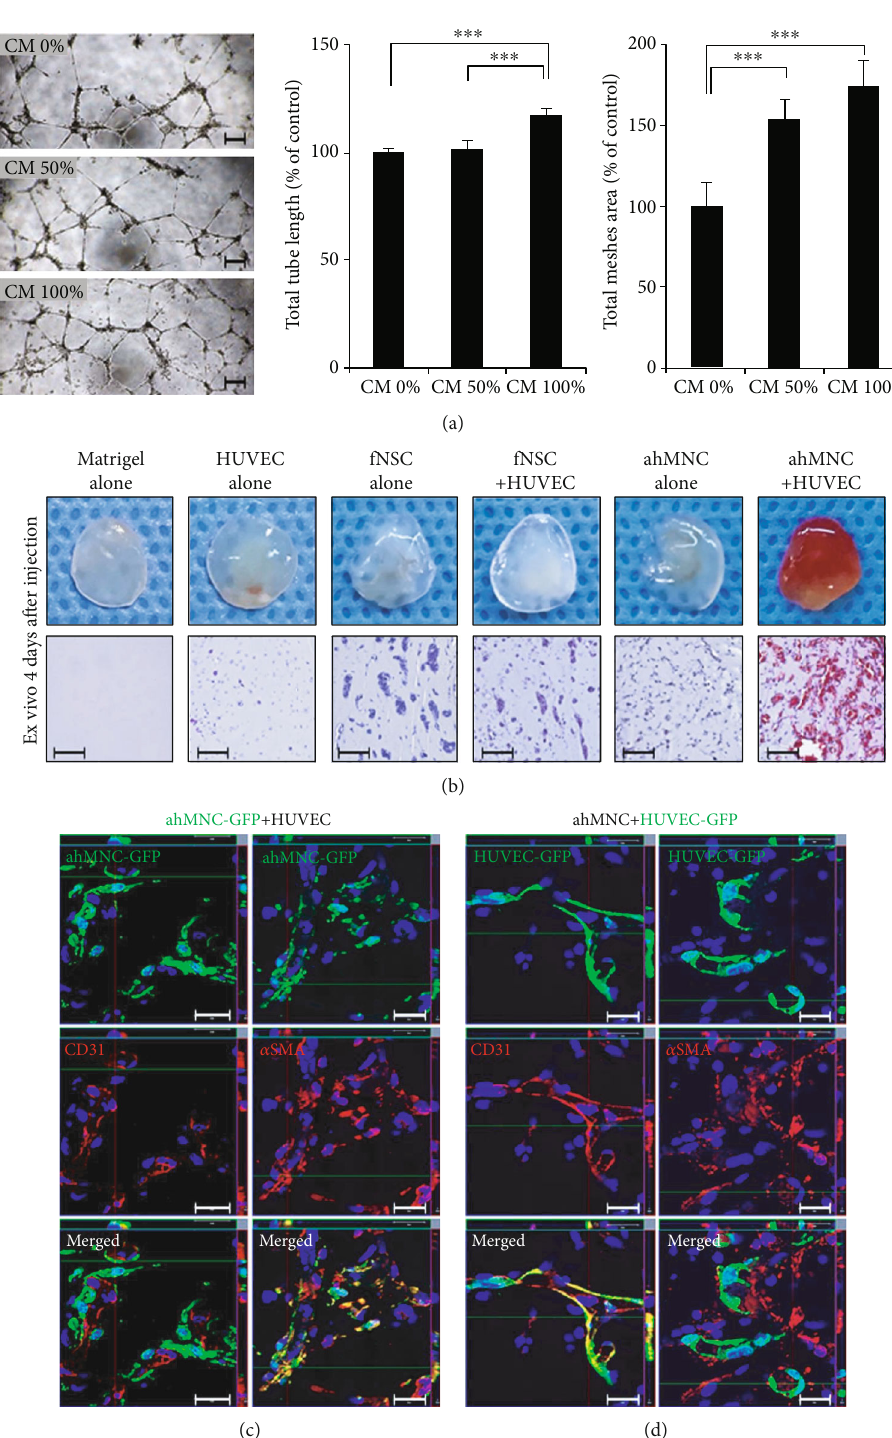
Figure 1: Proangiogenic activities of ahMNCs. (a) In vitro tube formation assay. Di ff erent ratios of CM of ahMNCs were applied to HUVECs in Matrigel for 18 h. Tube length and mesh area were analyzed and compared. Scale bar, 200 μ m. Height = average, errorbar = SD . ∗∗∗ P < 0 : 01 . Representative data (001TL) of triplicated experiments are shown. (b) In vivo Matrigel plug assay. 2 × 10 6 cells at ratios of 100 :0, 50 :50, or 0: 100 (HUVECs : fNSCs or HUVEC : ahMNCs) in Matrigel were transplanted subcutaneously into dorsal surfaces of Balb-c/nu mice. Four days after transplantation, in vivo angiogenesis was analyzed histologically. Scale bar, 100 μ m. Representative data (015TL) of triplicated experiments are illustrated. (c, d) After transplantation of ahMNCs tagged with GFP and HUVEC (c), or ahMNCs and HUVEC tagged with GFP (d), their localization was analyzed by immuno fl uorescence. Scale bars, 20 μ m. Representative data (001TL) of triplicated experiments are